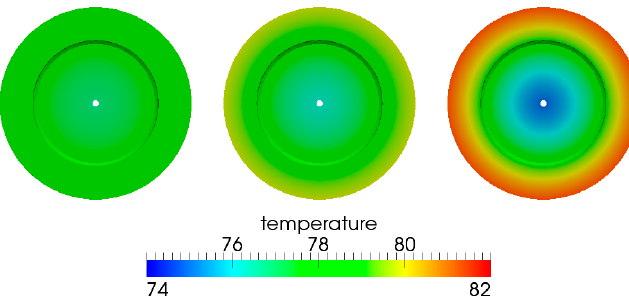
Figure 18. Cylinder block temperature distribution comparison for different sizes.